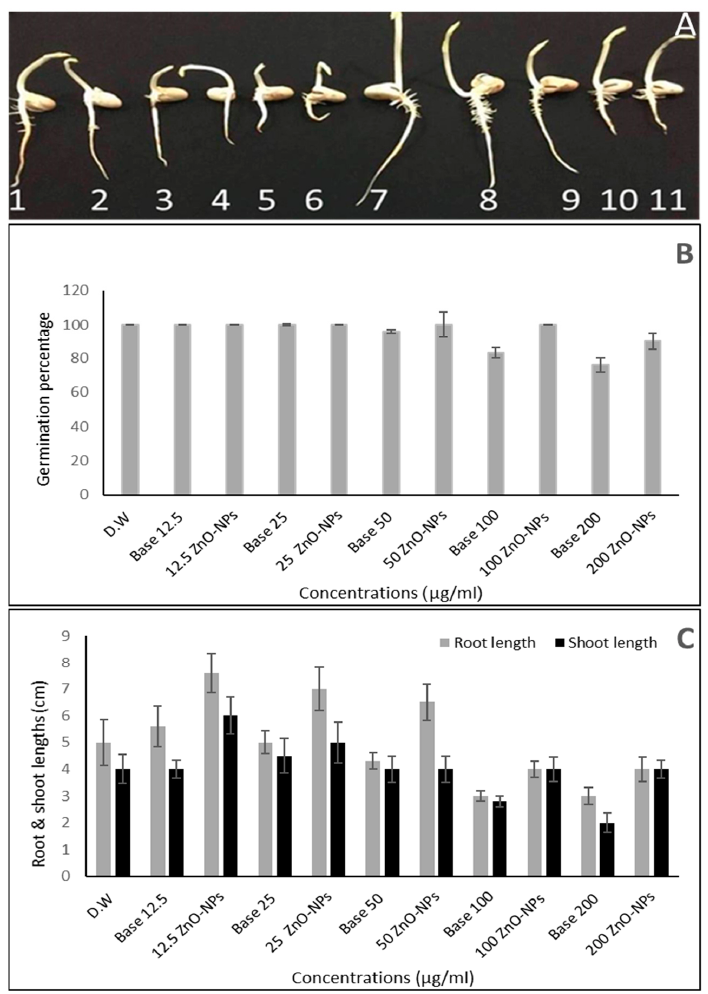
Figure 9. Effects of various ZnO ‐ NP concentrations on Vicia faba. ( A ) The treated plants’ morpho